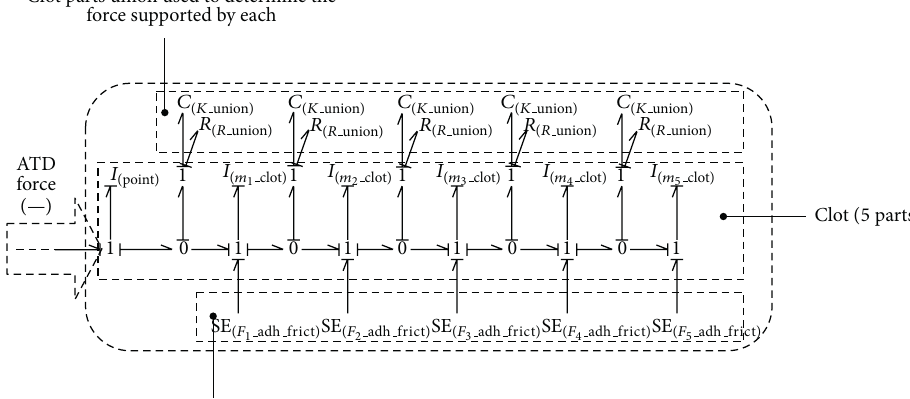
Figure 8: The simplest blood clot model by Bond-Graph